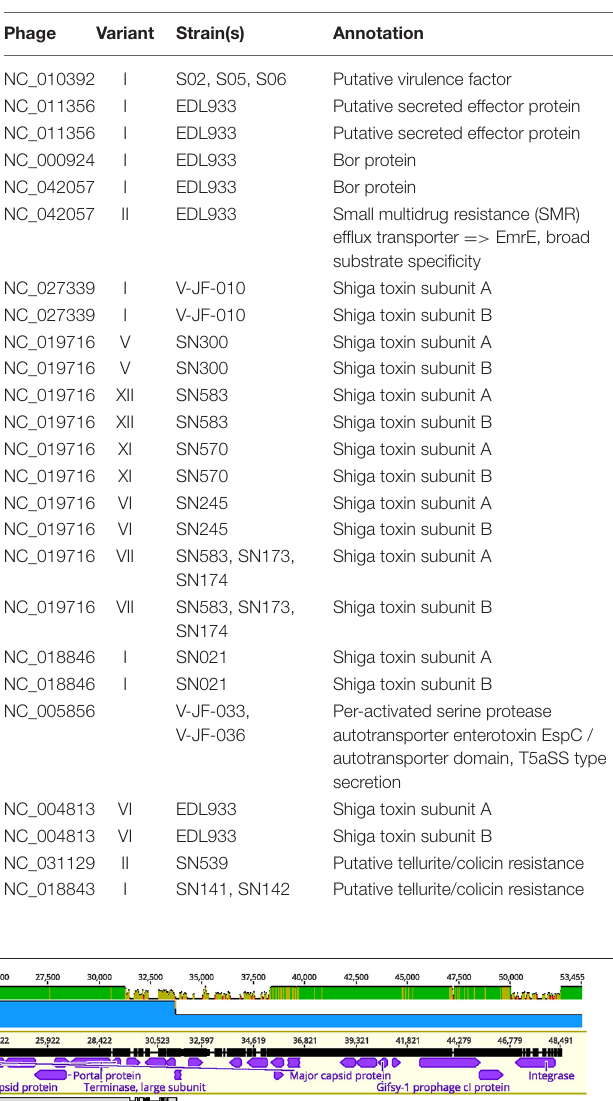
TABLE 2 | Putative virulence genes carried by the prophages identified in this study.